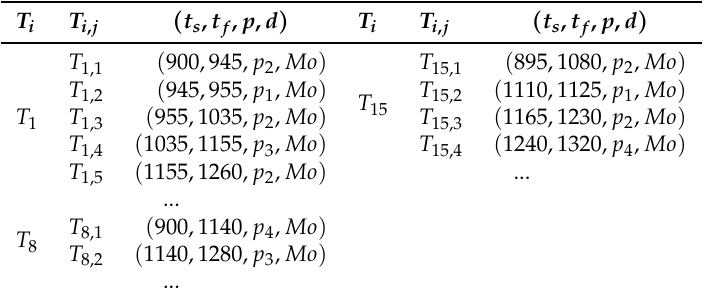
Table 2. ST trajectory